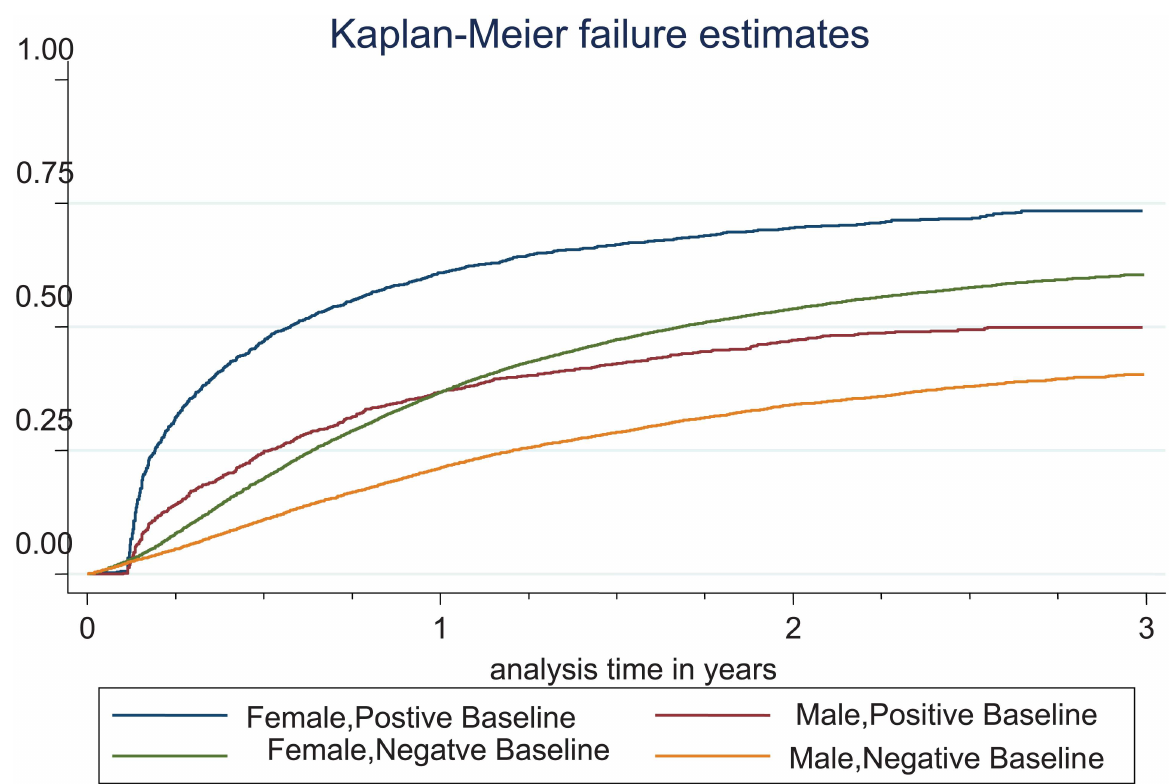
Fig 1. Kaplan-Meier failure estimate curves for incidence of repeat testing at the YHC Stockholm County stratified by sex and baseline status.